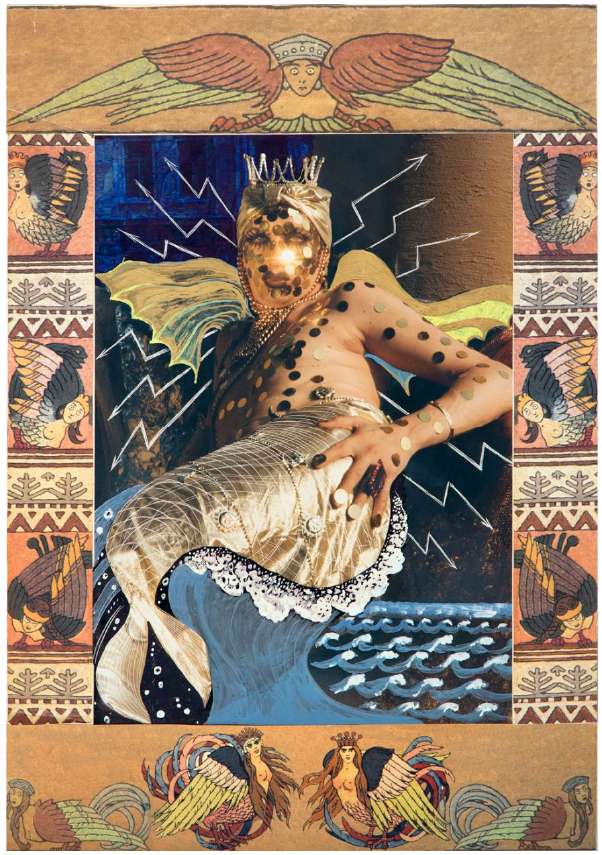
Figure 7. Vlad Mamyshev-Monroe. From the series “The Russian Questions” (1997), https://vmmf.org/series/view?id=6#work-series-6-5 (accessed on 11 September 2022).